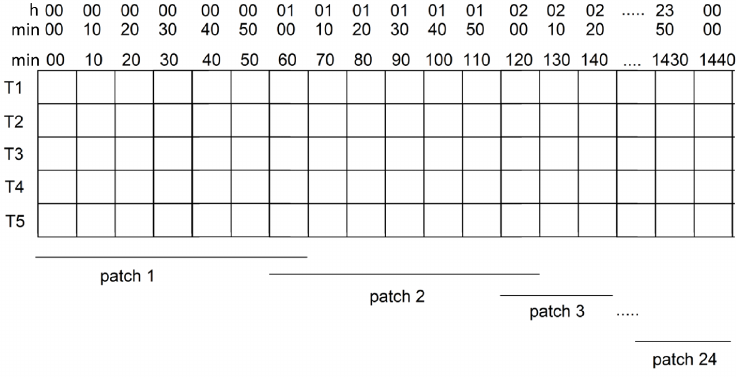
Figure 3. Approximation surface patches on measured